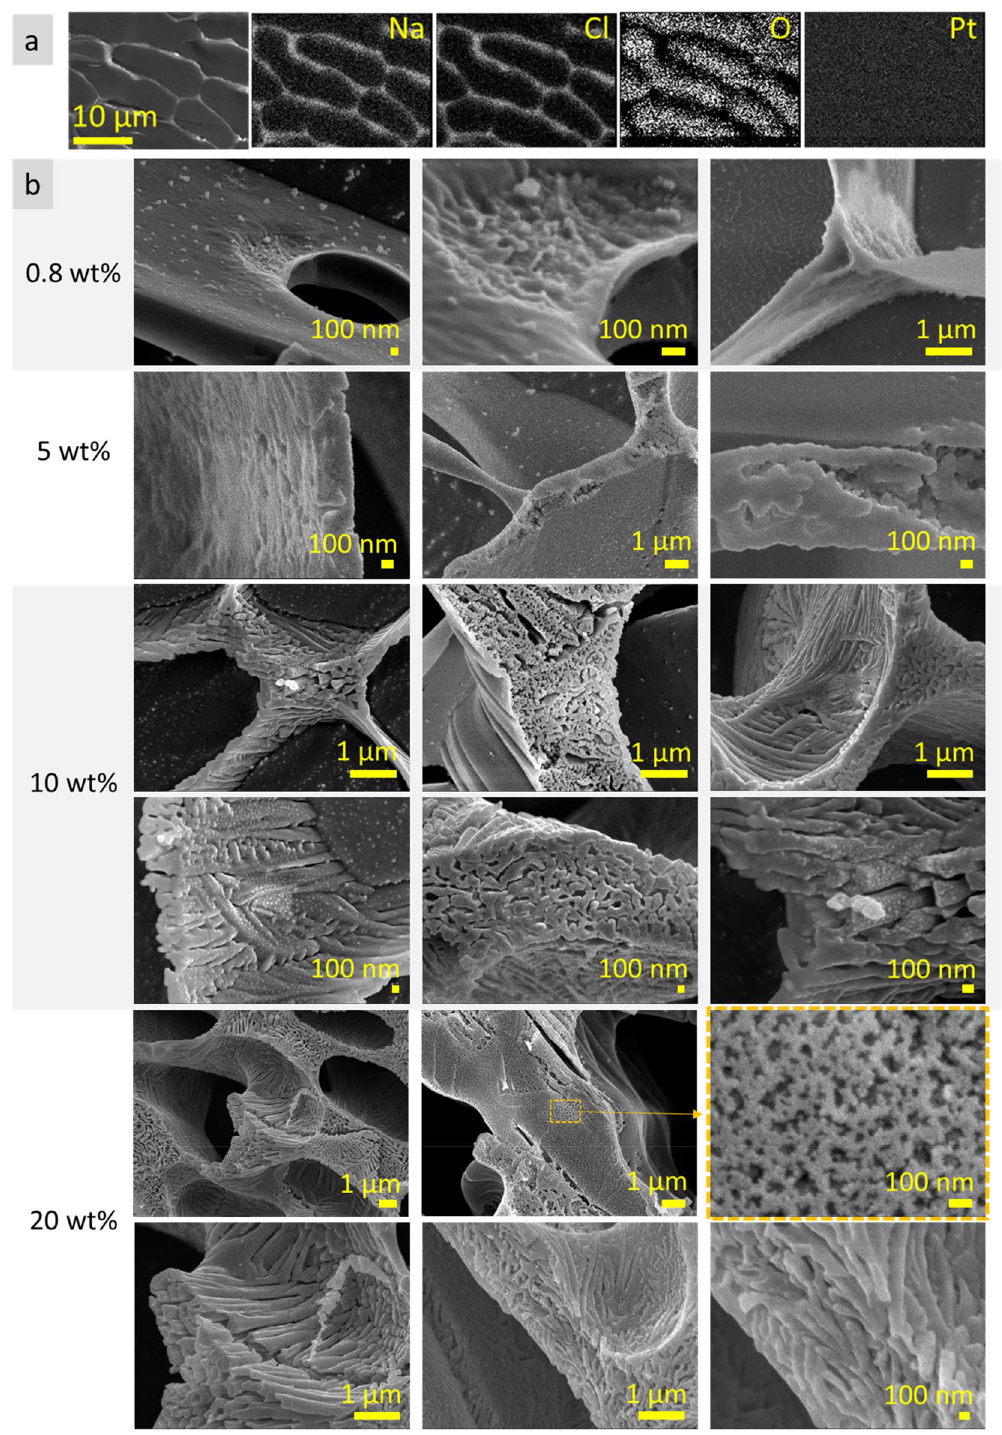
Figure 8. Cryo-SEM EDS elemental mapping of 10 wt% NaCl solution: Na, Cl, O and Pt elemental distribution. Pt was used for plasma sputtering, its homogenous distribution indicates that microstructural elements from the sample did not overtop surface influencing the electron flow ( a ). Cryo-SEM images of NaCl solutions (0.8–20 wt%): microstructure at nanoscale level ( b